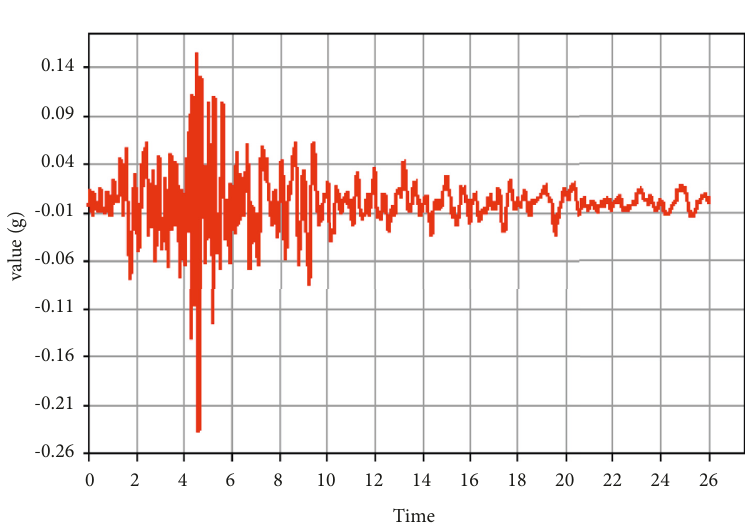
Figure 5: Seismic wave I (0.1524g).